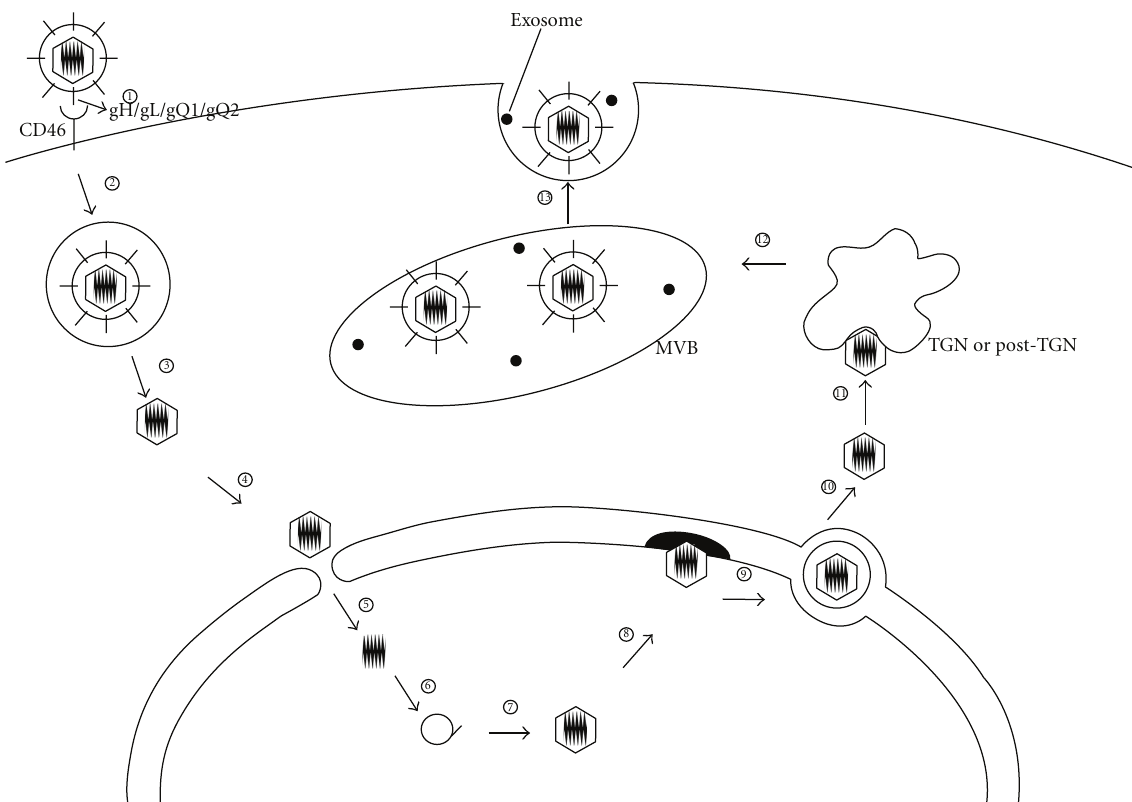
Figure 1: Schematic representation of the HHV-6A replication cycle. A diagram of the proposed replication cycle for HHV-6A is shown. HHV-6A gH/gL/gQ1/gQ2 binds to CD46 (1) and enters the cell via endocytosis (2). The deenveloped nucleocapsid is then transported to the nucleus (3, 4), where the viral genome is released (5). After viral gene transcription and genome replication (6), the progeny DNA is encapsidated (7), and the capsid buds into the perinuclear cisternae (8). The capsid acquires a primary envelope in the perinuclear space (9), and deenvelopment occurs in the cytoplasm (10). The nucleocapsid acquires the final envelope by budding into TGN- or post-TGN-derived membrane (11). Vacuoles containing virions expand and form MVBs (12), then the mature enveloped virions are released via the exosomal pathway